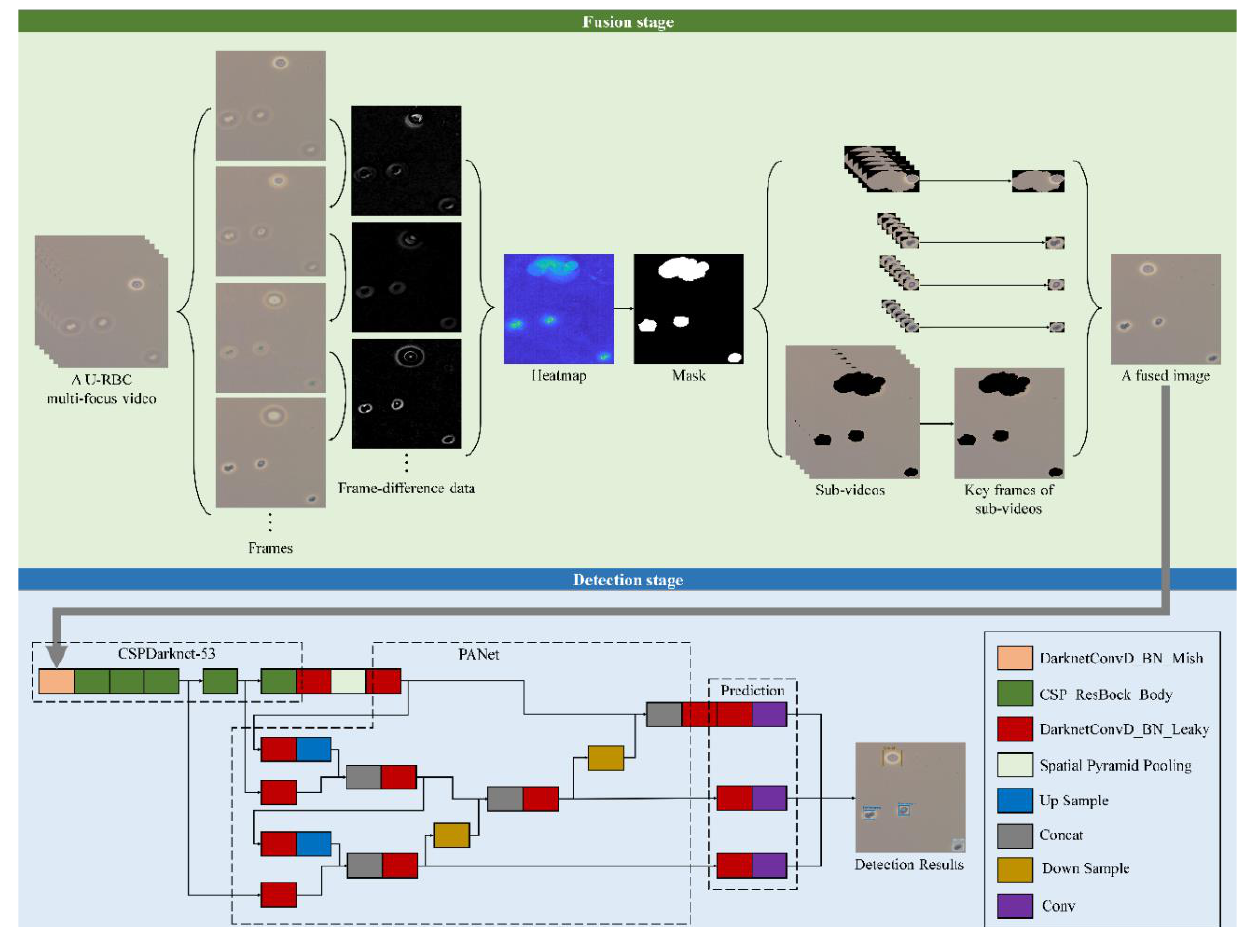
Figure 1. The overall framework of